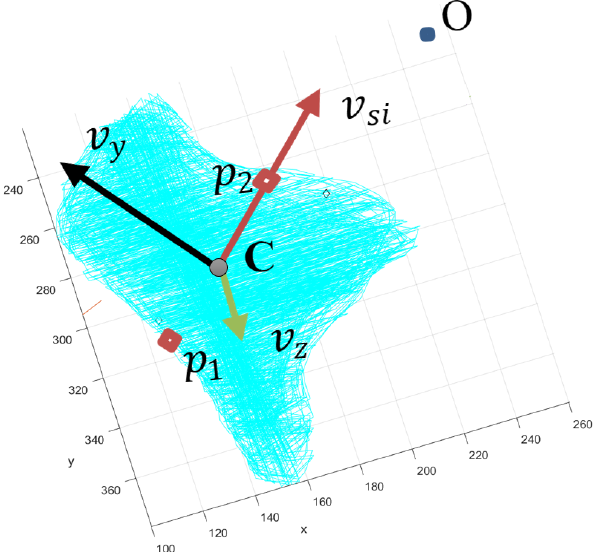
Figure 4. Illustration of fat-pad along with its eigenvectors and obtained boundary